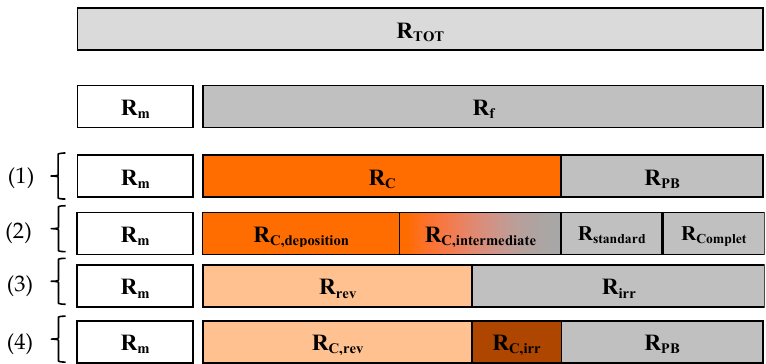
Figure 5. Logical scheme of RIS model based on the cake layer removal by means of physical cleaning.